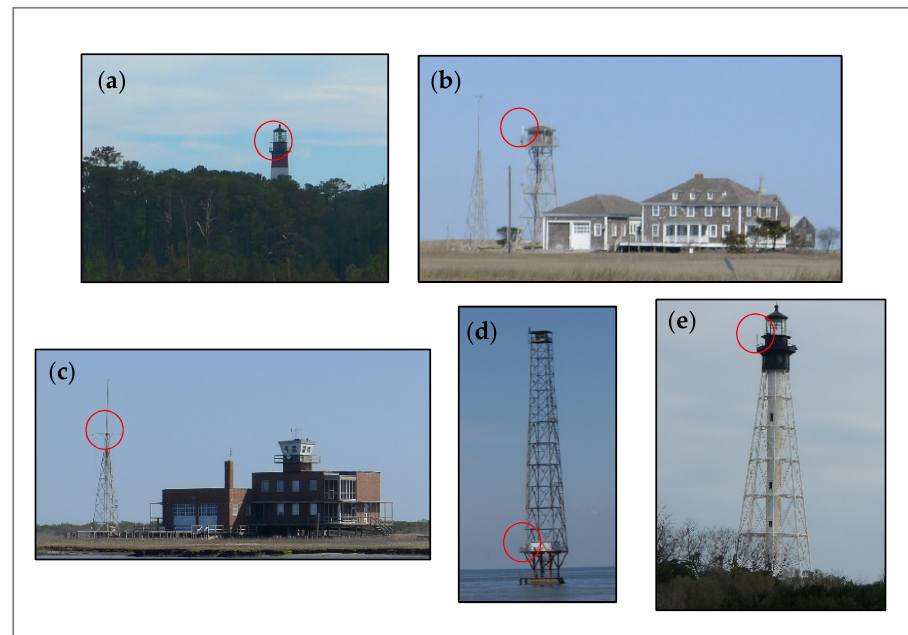
Figure 2. Lighthouses and structures serving as infrastructure for acoustic bat detector deployment on Eastern Shore of Virginia, USA, 2012–2019. Acoustic detector microphone locations are indicated by the red circles. Labels correspond to the locations given in Figure 1: ( a ) Assateague Island (Assateague Lighthouse); ( b ) Cedar Island (inactive United States Coast Guard station); ( c ) Hog Island (inactive United States Coast Guard station); ( d ) Silver Beach (offshore navigation light structure); ( e ) Smith Island (Cape Charles Lighthouse).